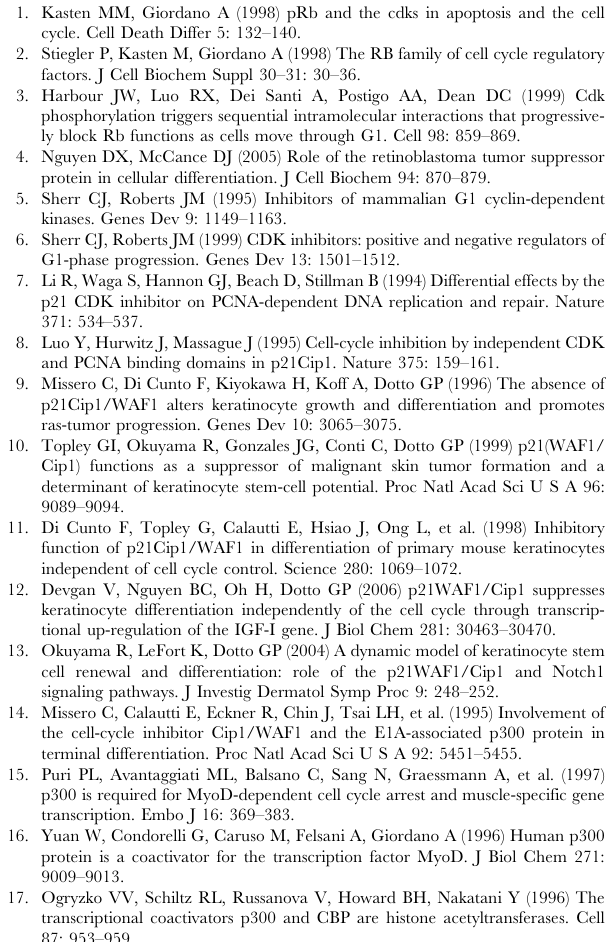
down rafts compared to control or CBP (lower panel). (D) Graph represents BrdU uptake expressed as percentage of scrambled control (mean + / 2 SE, two independent experiments). is required for its activity in differentiation. (A) Schematic representing reporter vectors used in panels B and C. For the p21 Waf1/CIP1 -mut1 reporter vector, the distal p53 binding site (RE1) was altered by site-direct mutagenesis to GAAAC. (B) HFKs cells were transfected with constructs shown in panel A. Loss of distal p53 response element inhibits the activation of p21 Waf1/CIP1 promoter in differentiating cells. (C) HFKs were transfected with a mutated p21 Waf1/CIP1 promoter luciferase reporter vector (p21 Waf1/CIP1 -mut1). Mutation of the distal p53 response element (RE1) abrogates the induction of p21 Waf1/CIP1 promoter activity during differentiation. All luciferase assays were normalized for